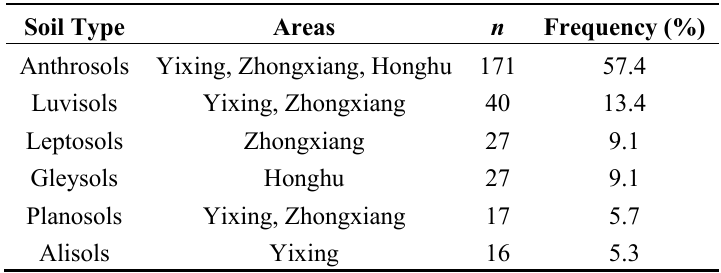
Table 2. The number of soil samples ( n ) and frequency (in percent of the total number of soil samples) occupied by soil type in the Harmonized World Soil Database (version 1.2) for the Yixing, Zhongxiang and Honghu